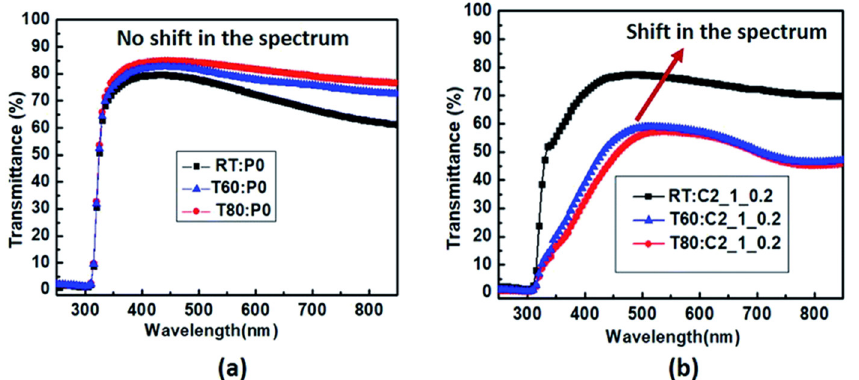
Figure 9. Transmission spectra for thin film samples of PEDOT:PSS at varying temperatures—room temperature (denoted as RT), 60 °C (denoted as T60) and 80 °C (denoted as T80) for ( a ) pristine PEDOT:PSS film ( b ) sample C2_1_0.2. Reproduced with the permission of Reference [36]. Copyright The Royal Society of Chemistry.